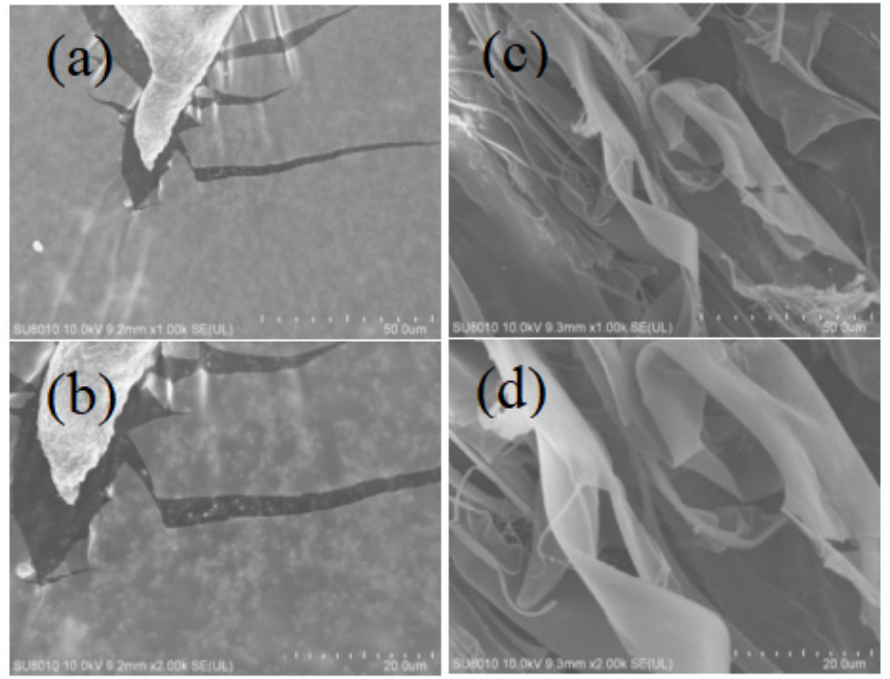
Figure 1. SEM picture of LJP and ULJP. ( a ) ×1.00 k and ( b ) ×2.00 k LJP; ( c ) ×1.00 k and ( d ) ×2.00 k ULJP. ( d ) × 2.00 k